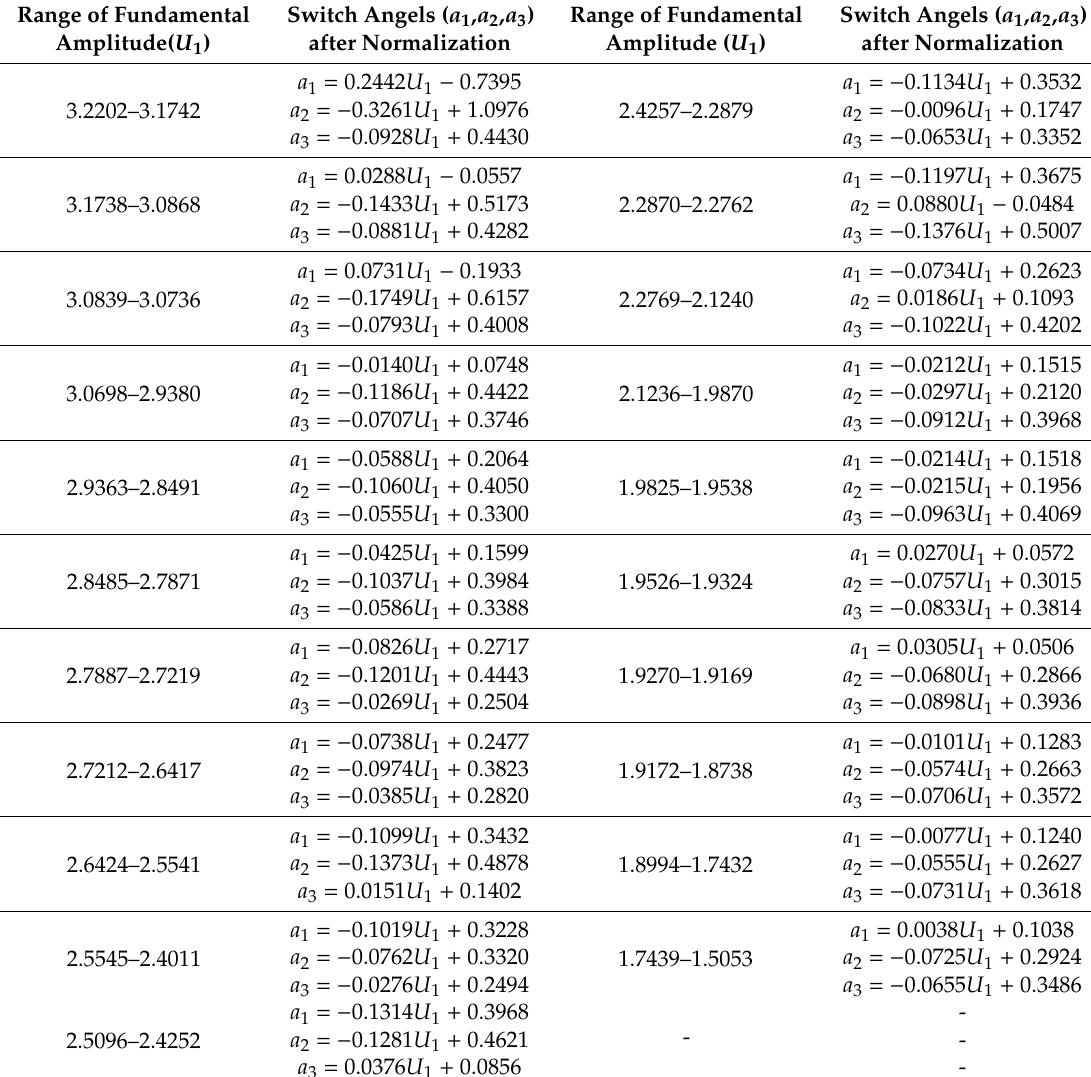
Table 4. Results of A waveband switching angles.